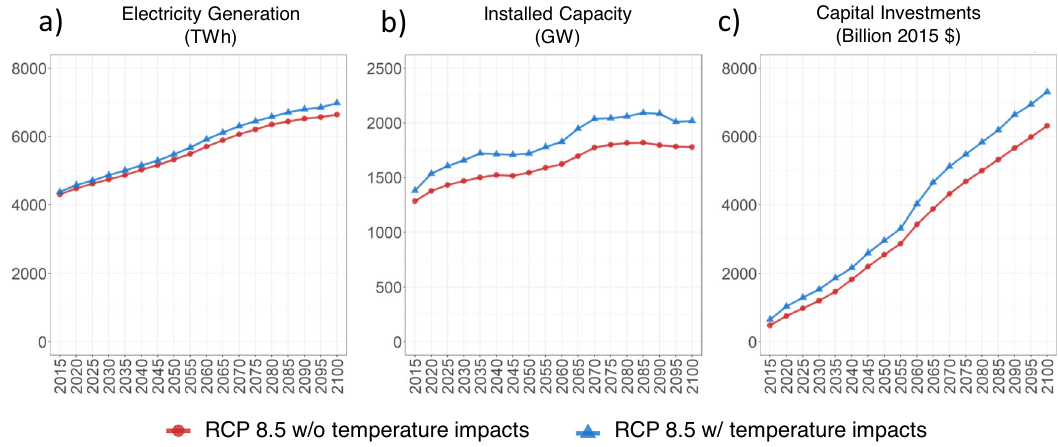
Fig. 3 Electricity generation (TWh), installed capacity (GW), and capital investments (billion 2015 $) from 2015 to 2100 for RCP 8.5 w/ and w/o temperature impacts. a U.S. total electricity generation (TWh), b installed capacity (GW), and c Cumulative capital investments (Billion 2015 USD), from 2015 to 2100 under RCP 8.5 w/o (red) and w/ (blue) temperature impacts. Note: Capital investments are in undiscounted USD. See Supplementary Table 2 for discounted